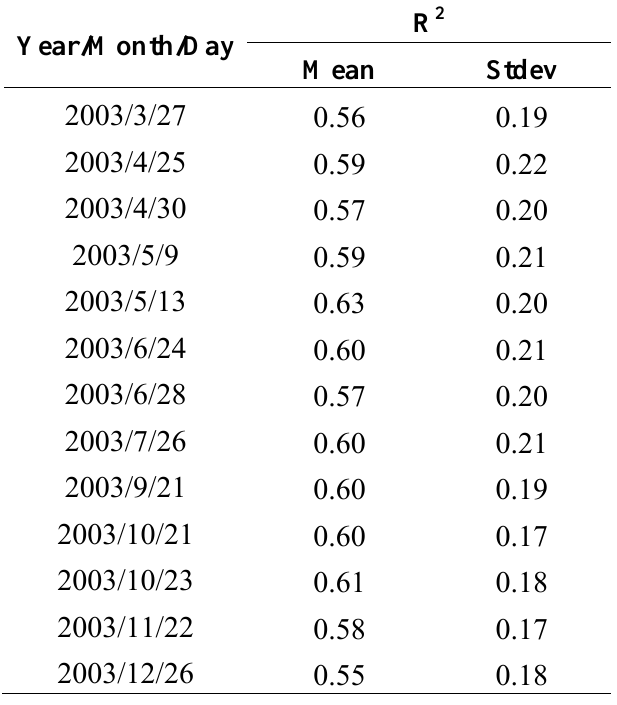
Table 3. R 2 for linear regression over the 28 pixels × 28 pixels area.